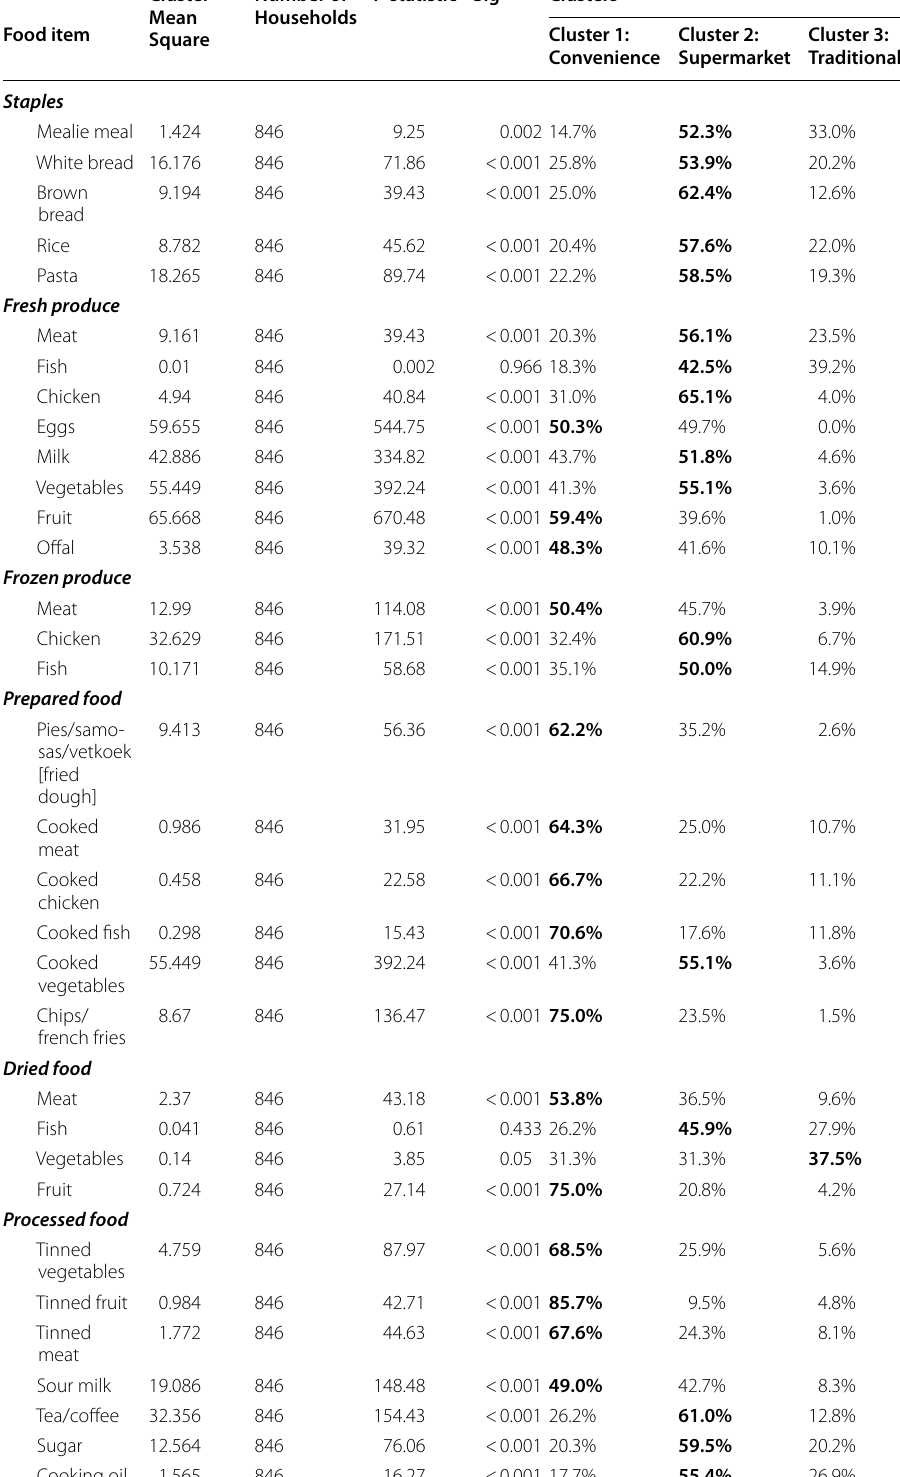
Table 4 HCFPM food clusters Cluster Number of F-statistic Sig Clusters Mean Households Food item Cluster 1: Square